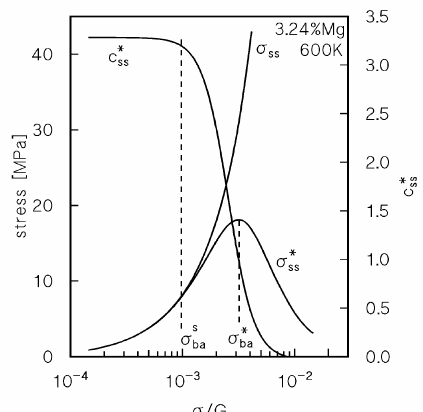
Figure 8. Plots for σ ∗ ss , c * and σ ss as a function of modulus compensated stress for 3.24%Mg at 600 K.